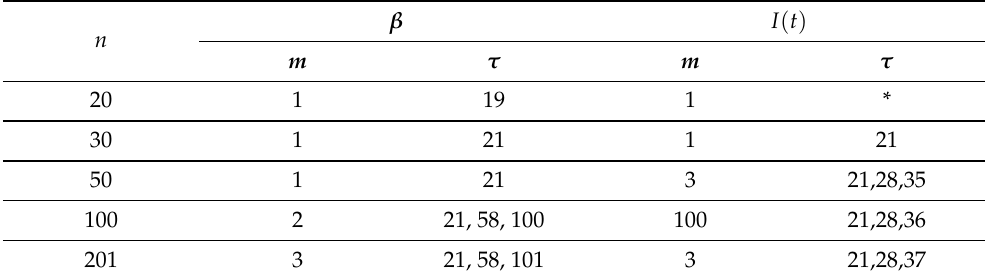
Table A7. BOCPD Algorithm Result for Simulated Transmissibility Rate and Infection.